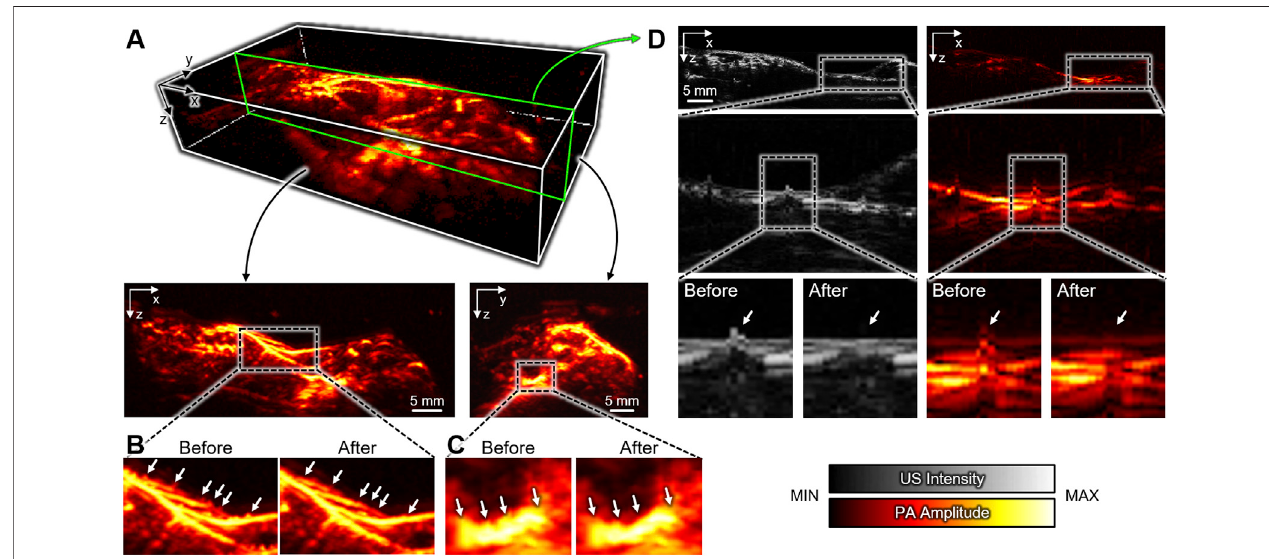
FIGURE 4 | Breath-compensated PA images. (A) 3D whole-body PA image and MAP images at the x-z and y-z plates after US-guided breath-compensation. Respiratory distortions in the (B) x-z and (C) y-z planes before and after breath-compensation. (D) Representative cross-sectional B-mode PA and US images showing the correction of respiratory distortion. Insets show the enlarged images. The green box in (A) depicts the corresponding position in the 3D image. US, ultrasound; PA, photoacoustic; MAP, maximum amplitude